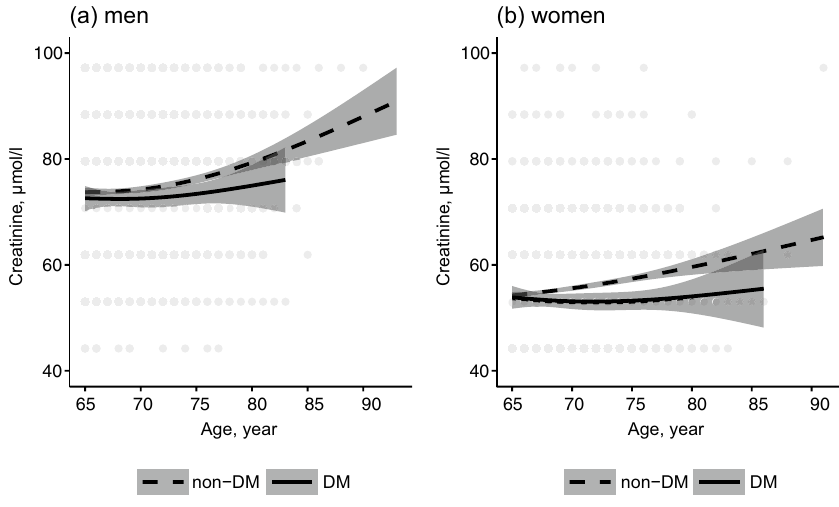
Figure 2. Linear regression line for creatinine levels against age stratified by diabetes status in ( a ) men and ( b ) women. The linear regression line with the natural spline function with 2 degrees of freedom was estimated according to the diabetes status, and the shaded areas indicate a 95% confidence interval. The oldest age was 83 years in men with DM, 86 years in women with DM, 93 years in men without DM, and 91 years in women without DM. DM diabetes mellitus.